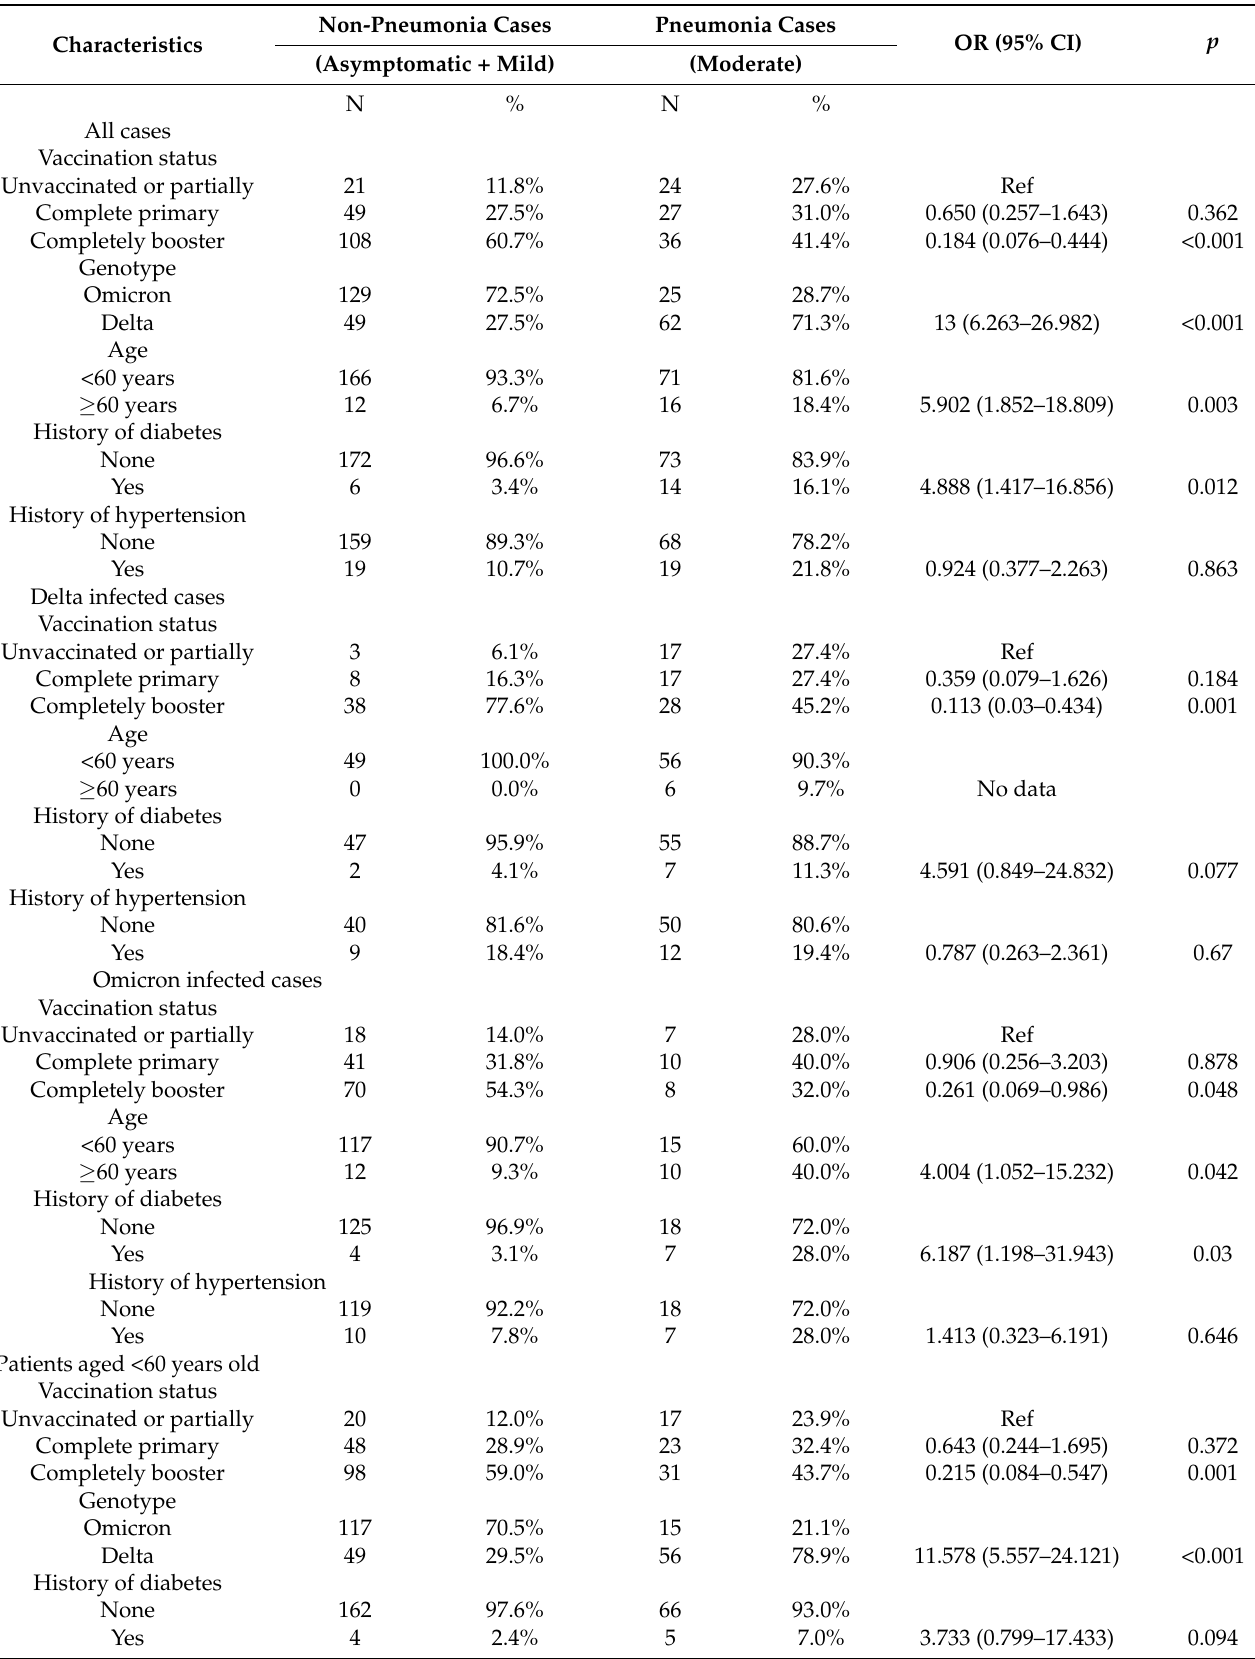
Table 2. Association between pneumonia cases and vaccination stratified by genotype and